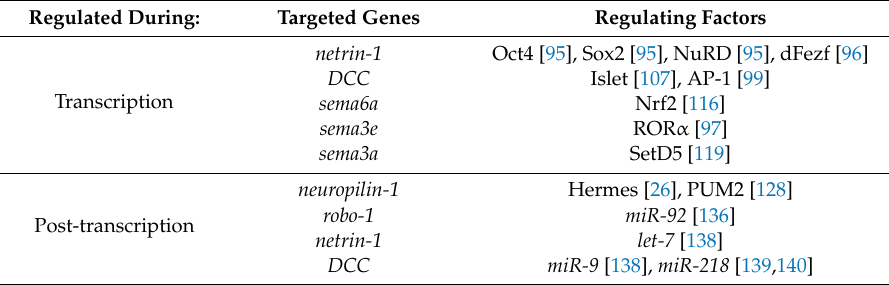
Table 1. Summary of factors that regulate gene expression of guidance cues and